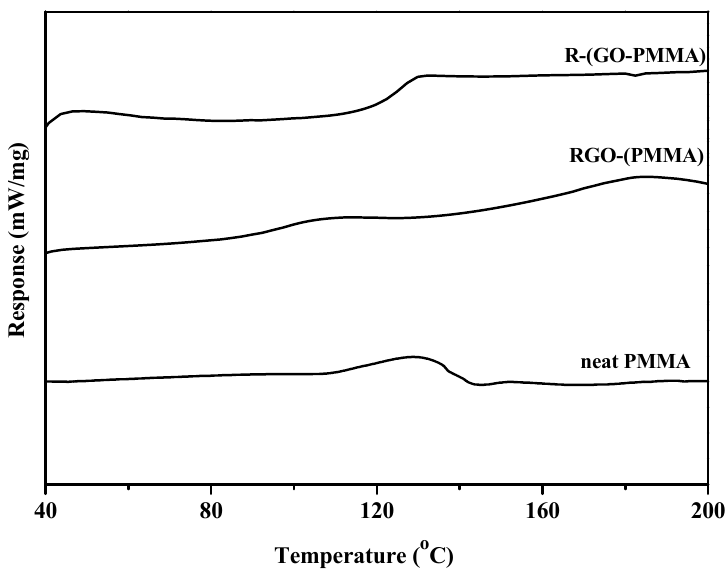
Figure 8. DSC thermograms of neat PMMA, RGO-(PMMA) and reduced R-(GO-PMMA) nanocomposites.